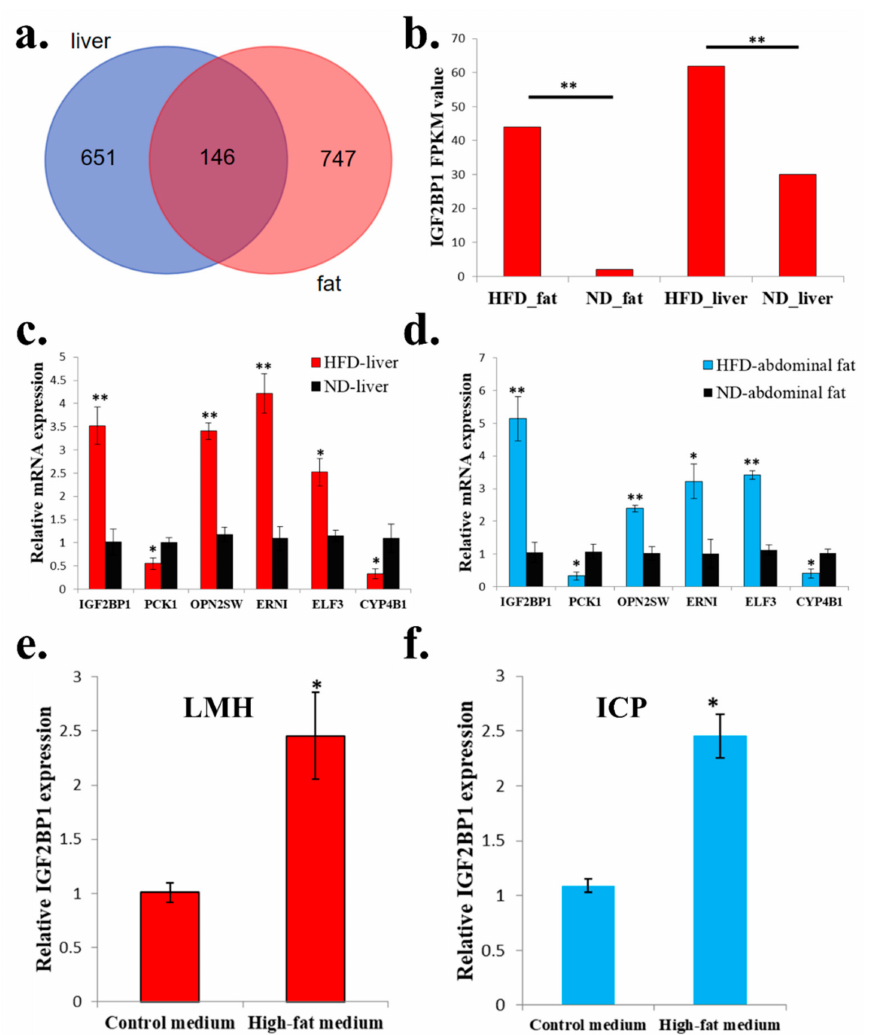
Figure 3. The expression of IGF2BP1 can be significantly induced in a high-fat condition. ( a ) Specific and common DEGs in liver and abdominal fat. The three groups of the Venn diagram represent the liver specific DEGs between HFD and ND chicken (blue), common DEGs between HFD and ND chicken in liver and abdominal fat (deep red), and abdominal fat specific DEGs between HFD and ND chicken (light red), respectively. ( b ) RNA-sequencing revealed that HFD can significantly induce IGF2BP1 expression in liver and abdominal fat of chicken. ( c ) qPCR validation of six DEGs obtained from RNA-seq in liver. ( d ) qPCR validation of 6 DEGs obtained from RNA-seq in abdominal fat. ( e ) High-fat medium can significantly promote IGF2BP1 expression in chicken LMH cell. ( f ) High-fat medium can significantly promote IGF2BP1 expression in chicken ICP cell. The data are mean ± S.E.M. with four samples (Figure 3b has three samples). Independent sample t -test was used to analyze the statistical di ff erences between groups. * p < 0.05; ** p <